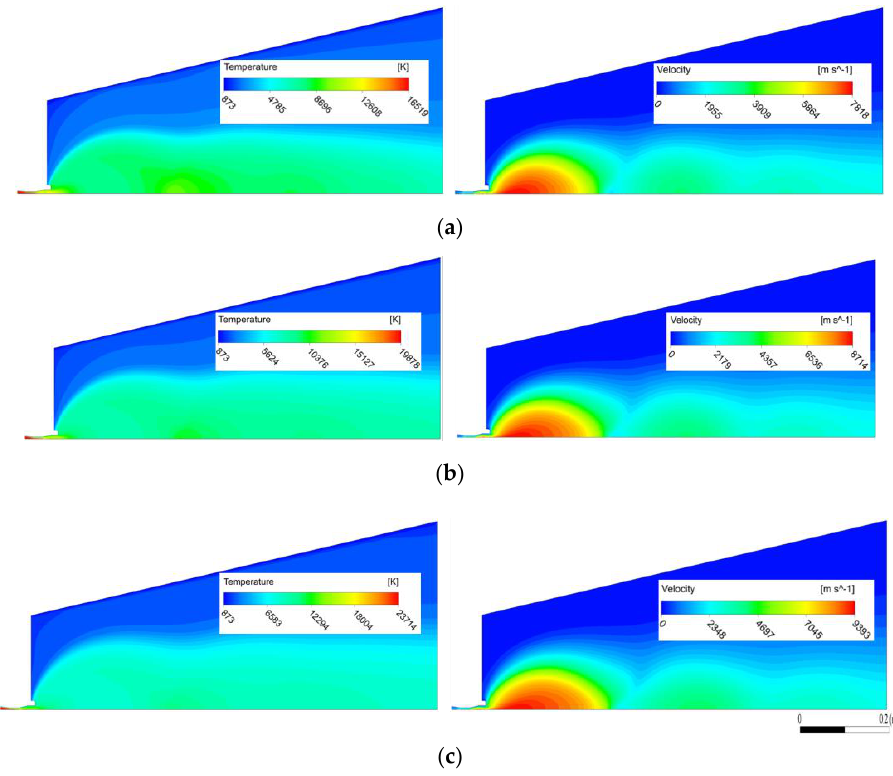
Figure 3. Temperature and velocity fields of the plasma jet for different net electric powers: ( a ) 40 kW, ( b ) 50 kW and ( c ) 60 kW. 40 SLPM of argon, 8 SLPM of hydrogen, chamber pressure: 100 Pa.